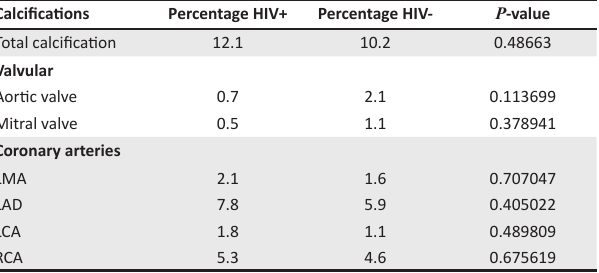
FIGURE 5: Demonstrates an increased probability to develop cardiac calcifications with an increase in age. TABLE 2: Comparison of the probability to develop cardiac calcification between HIV positive and HIV negative cohort